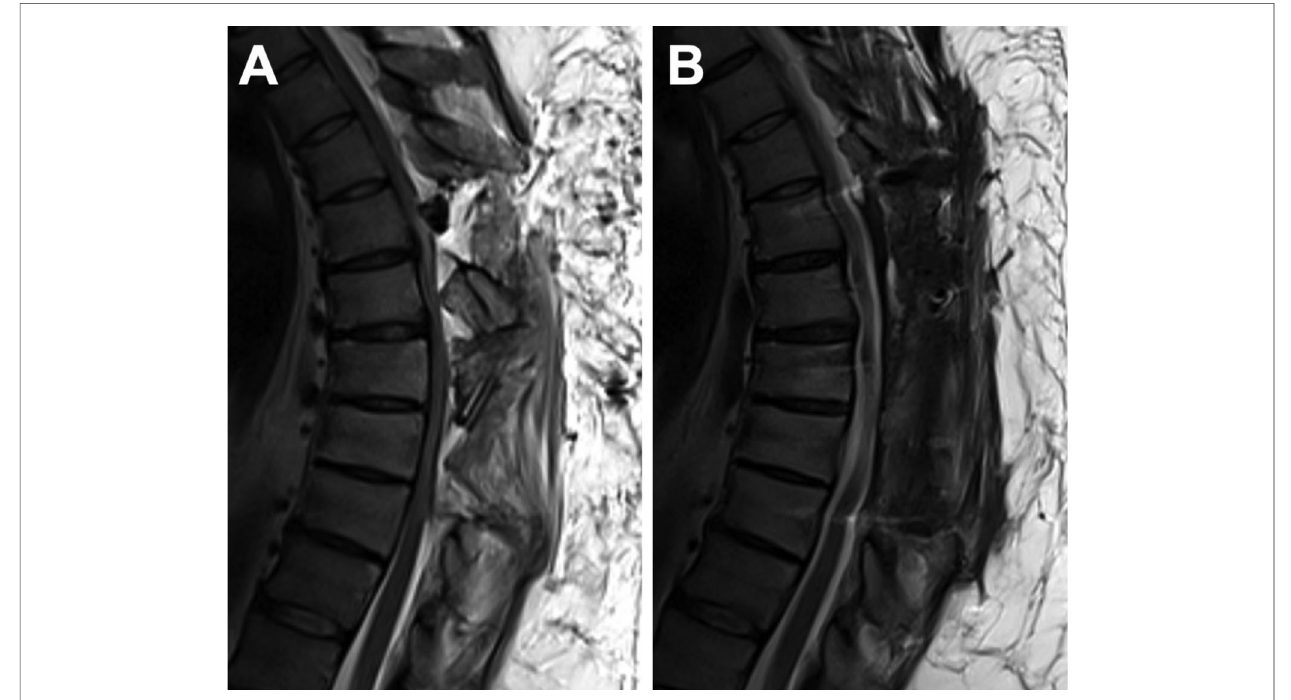
FIGURE 2 | Surgical resection and decompression. ( A ) Sagittal T2-weighted MRI of the thoracic spine after initial resection and decompression, prior to stabilization. ( B ) Three-month follow up sagittal T2-weighted MRI after further decompression and stabilization, without residual spinal